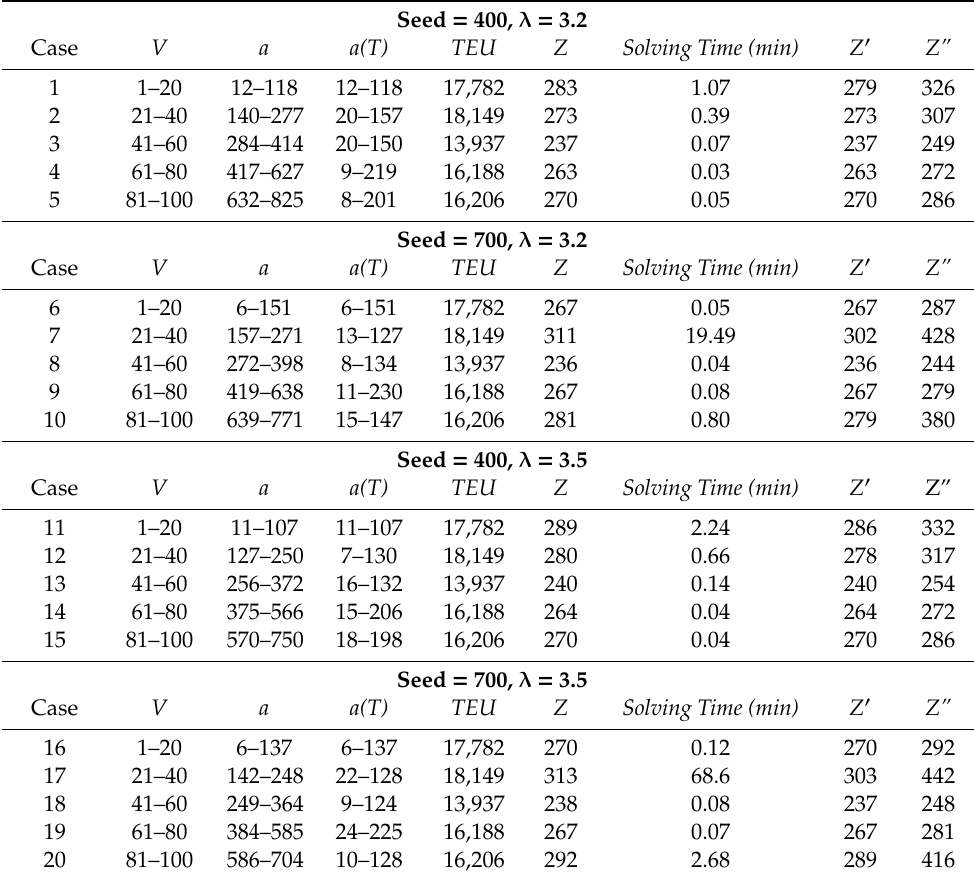
Table 4. Results of the BAP and QCAP integrated problem for 20 cases. Seed = 400, λ =